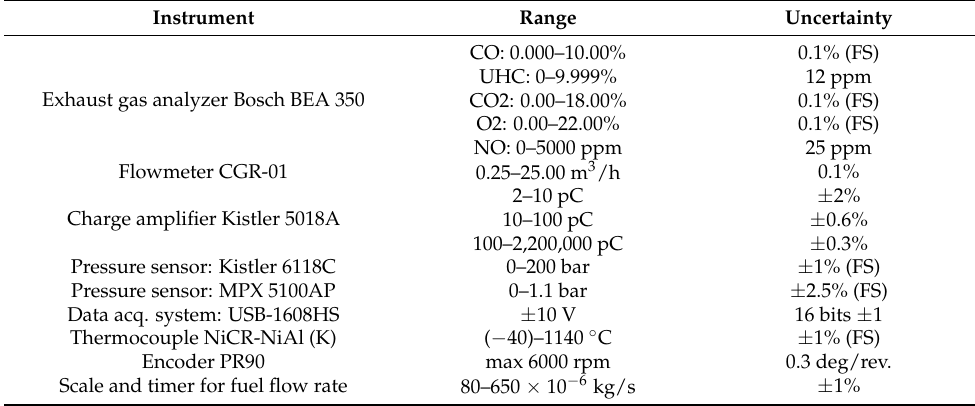
Table 5. Instrumentation of the measurement